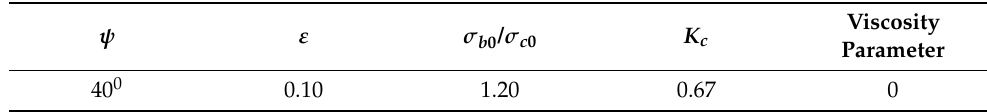
Table 7. Plasticity parameters adopted in Abaqus for the numerical